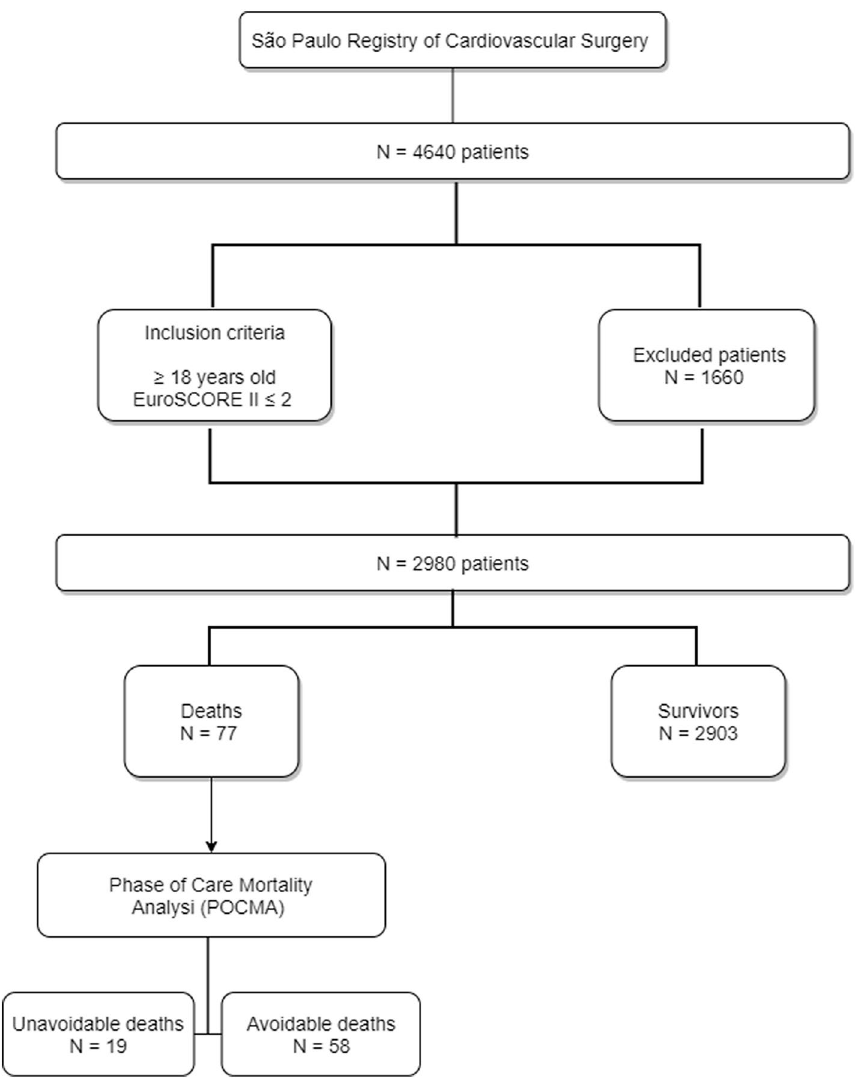
Figure 1. Flowchart of patient selection in the São Paulo Phase of Care Mortality Analysis study. Description about the selection of patients used for this